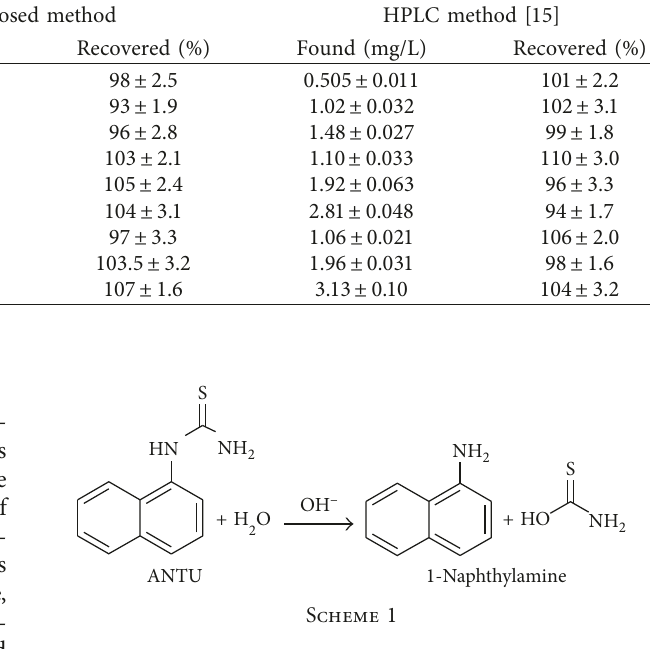
Table 3: Percent recovery of ANTU in spiked natural water samples ( n � 4). Sample matrix